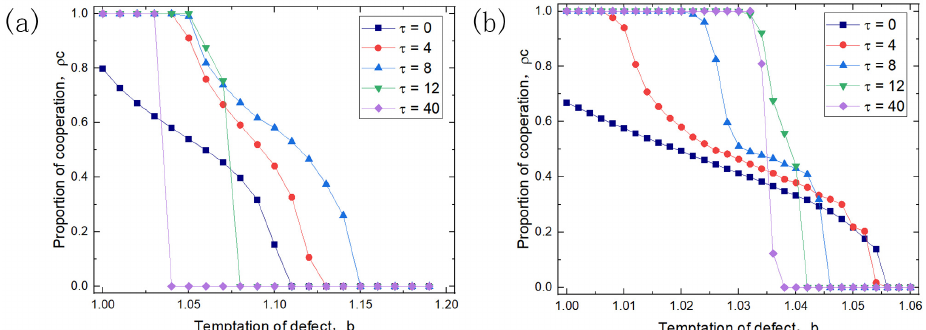
Figure 7. Comparison of the evolution of cooperation under the corresponding coupled relation- ship and random coupled relationship. Subgraph ( a ) is the results obtained under the corresponding coupled relationship, while subgraph ( b ) is the ones gained under the random coupled relationship. It should be noted that, due to the fact that the results obtained on both networks are qualitatively consistent, only the results obtained on bottom network are shown here. Other parameters are exactly the same as those in Figure